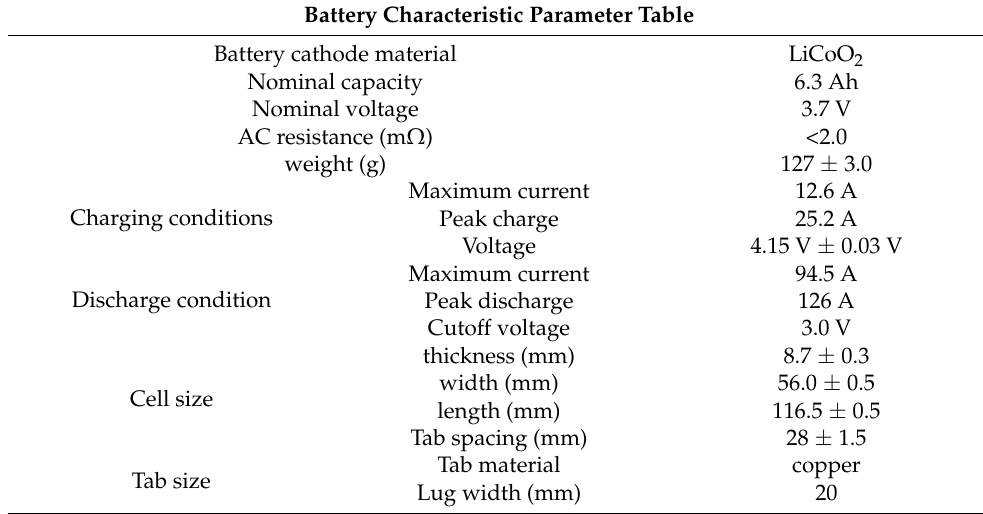
Table 1. Battery characteristic parameter